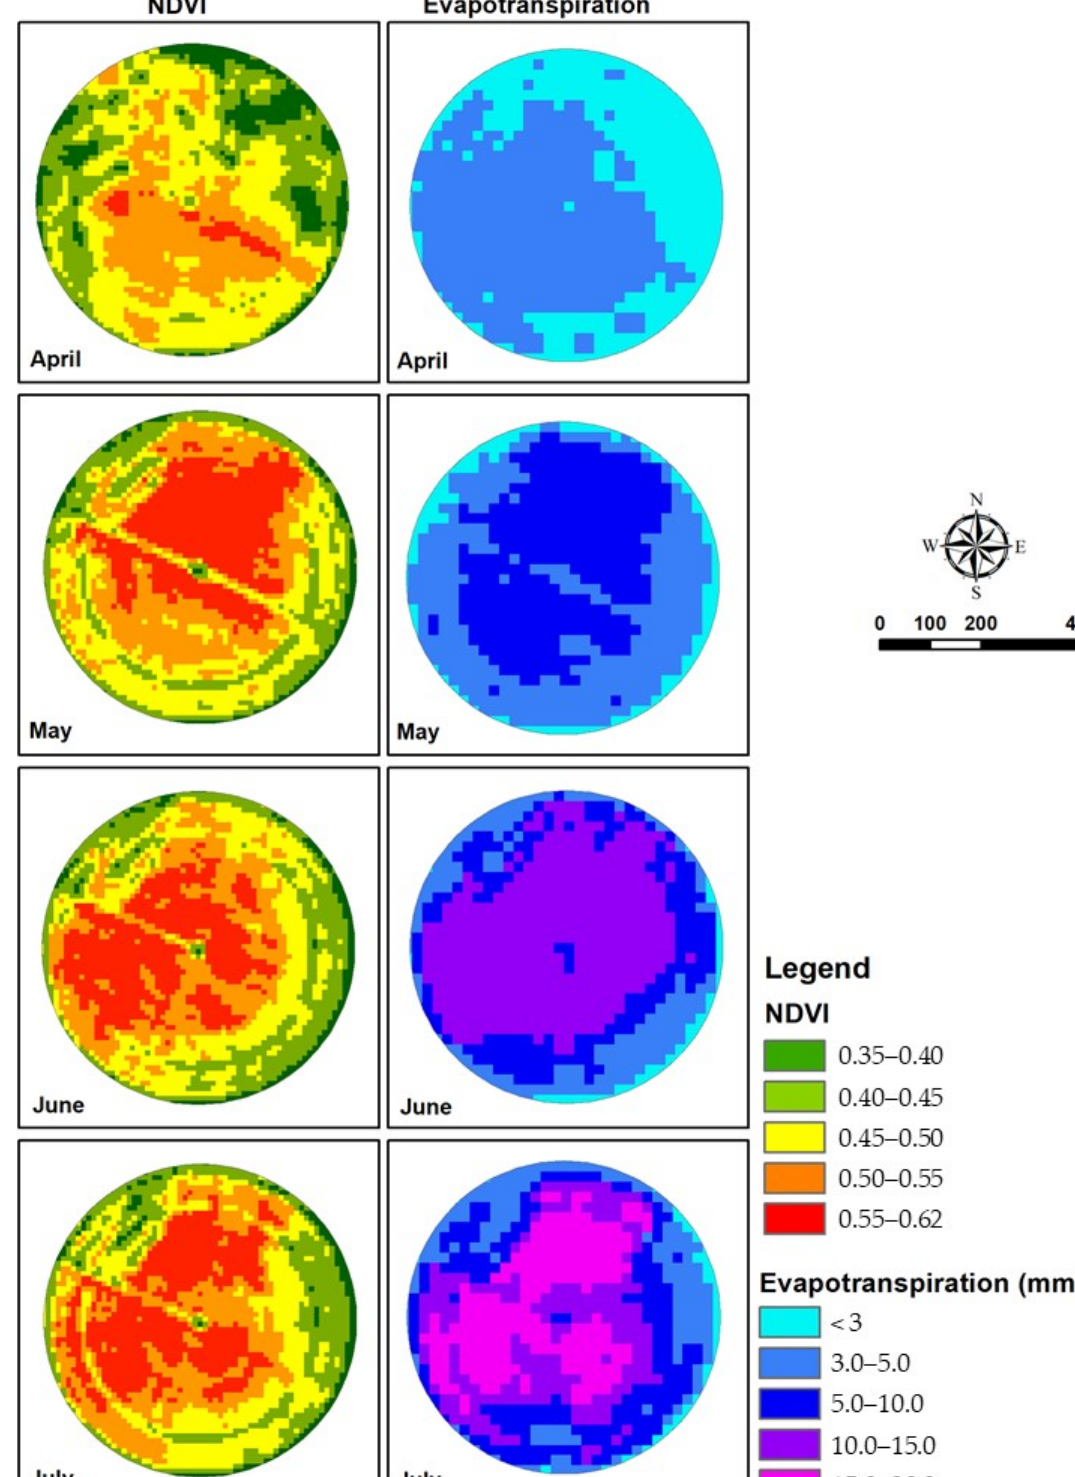
Figure 7. Monthly mean NDVI and evapotranspiration maps of carrot